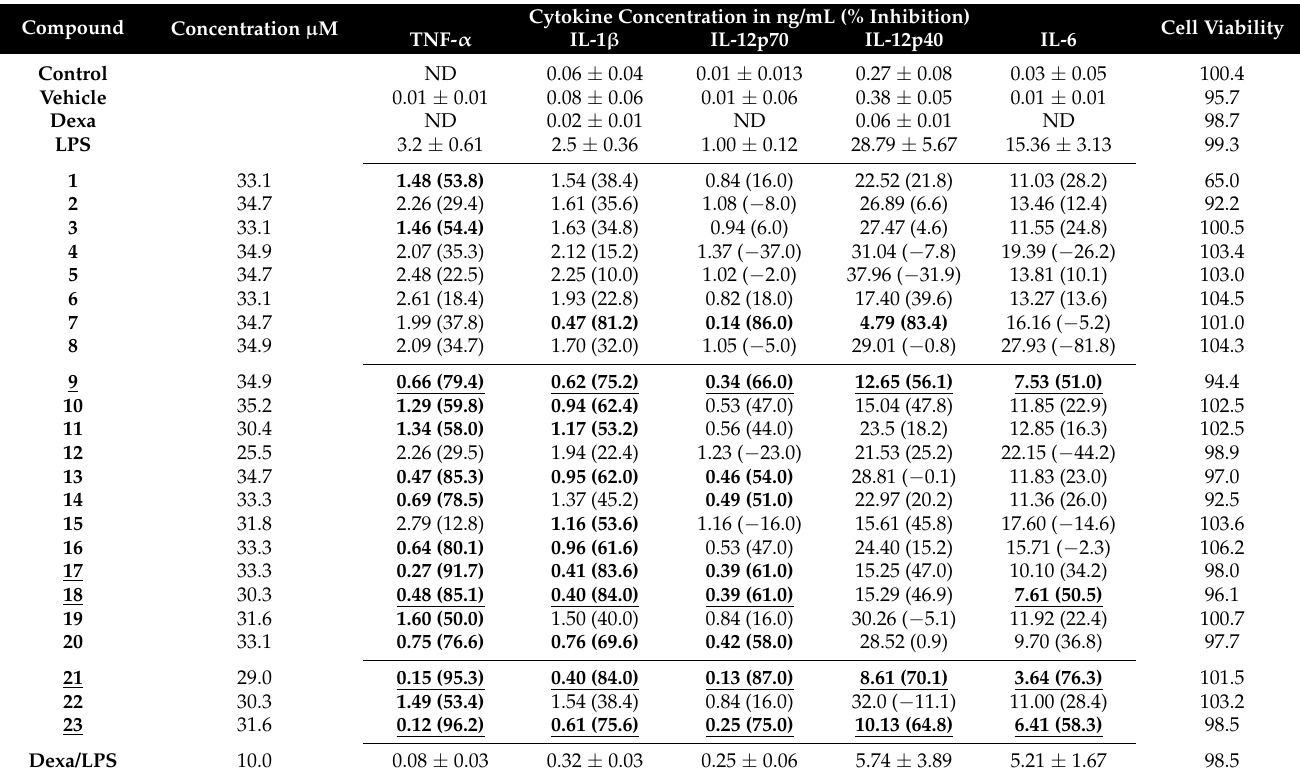
Table 1. Screening for the cytokine-inhibiting activity of 23 semisynthetic abietane diterpenes at 10 µ